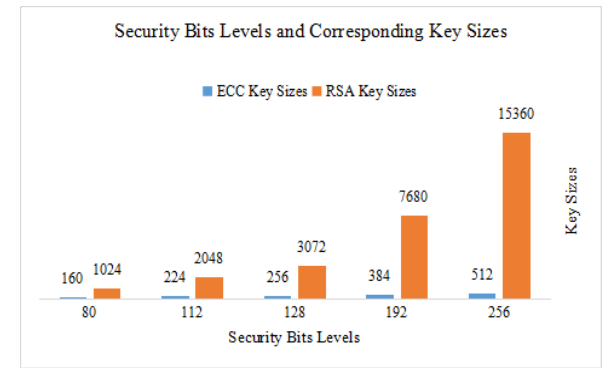
Figure 1. Key Size (NIST Recommended)[2]